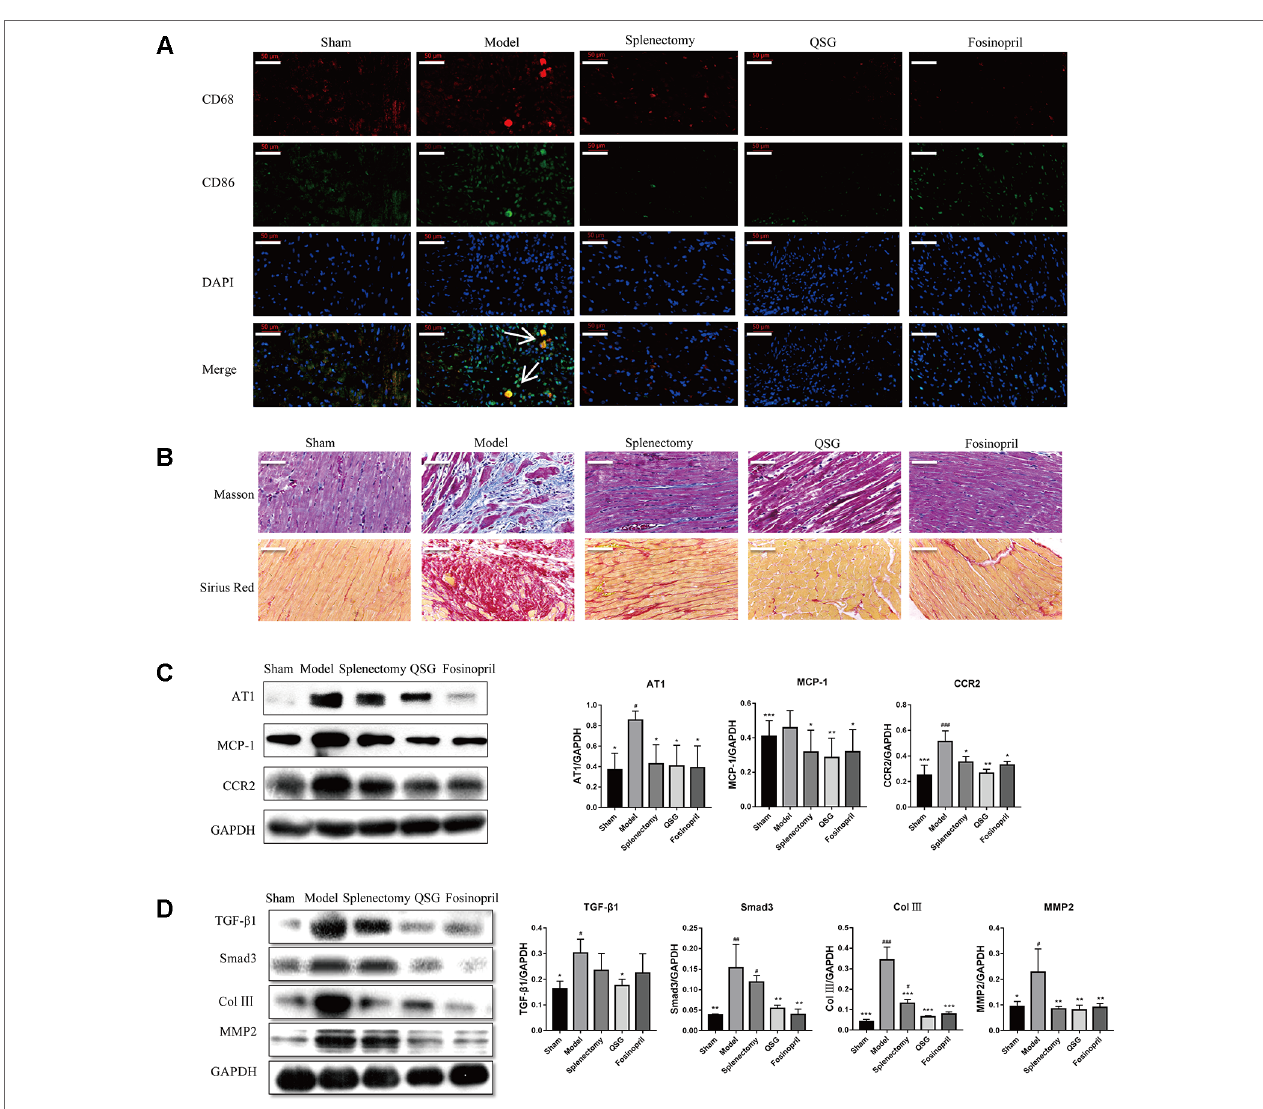
FIGURe 2 | QSG inhibited activation of TGF-β1/Smad3 through reducing the recruitment of M1 macrophages in myocardial tissue. (a) IF staining showed that splenectomy reduced the recruitment of M1 macrophages in myocardial tissue; QSG treatment decreased the recruitment of M1 macrophages. (B) Masson and Sirius Red staining showed that QSG inhibited cardiac fibrosis. (C) Western blot showed that QSG down-regulated the expressions of AT1, MCP-1 and CCR2 in myocardial tissue compared with that in the model group. (D) Western blot showed that QSG decreased the expressions of TGF-β1, Smad3, collagen III and MMP2 in cardiac tissue. All data were presented as means ± SD from independent experiments performed in triplicate. # P < 0.05, ## P < 0.01, ### P < 0.001 vs the sham group; * P < 0.05, ** P < 0.01, *** P < 0.001 vs the model group. N = 3 per group.